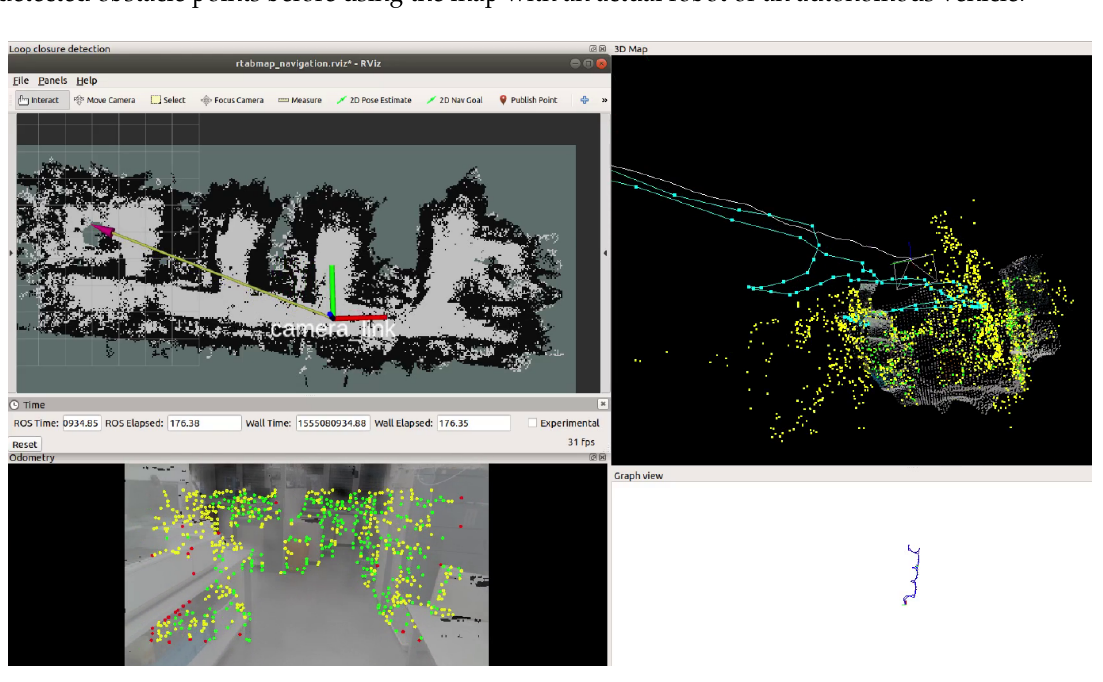
Figure 8. Output of the RTAB-Map Visualizer during navigation. Colour codes: Cyan and Blue = trajectory, Green = Inliers, Yellow = Not matched features from previous frame(s), Red =